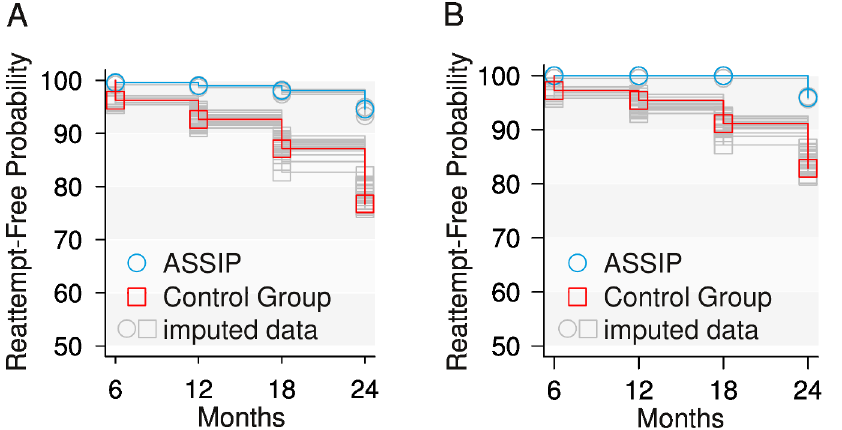
Fig 2. Survival curves. Suicide-attempt-free survival of participants who attempted suicide at least once during the 24-month follow-up period. (A) All participants ( n = 120). (B) Participants without BPD ( n = 100).